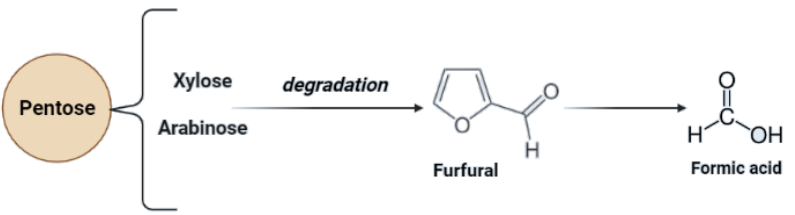
Figure 4. Chemical structures of inhibitory compounds are generated due to secondary transformations of pentoses during alkaline pre-treatment.